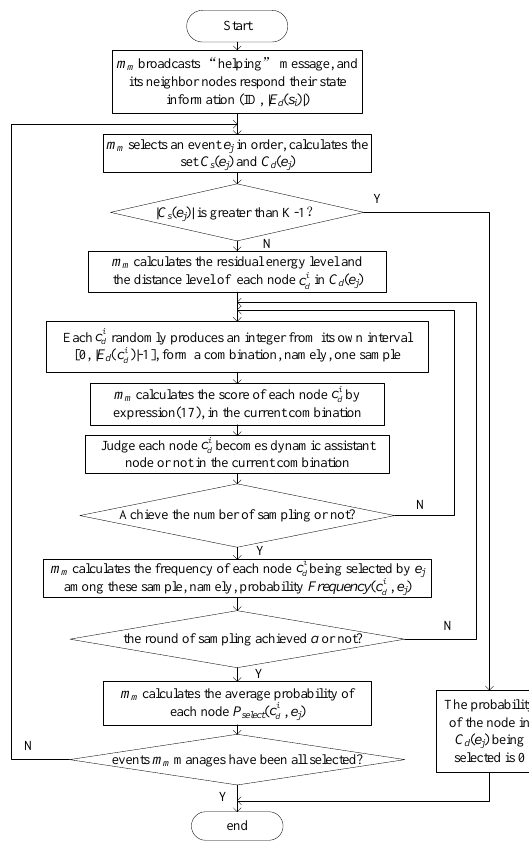
Figure 4. Flowchart of node selection.